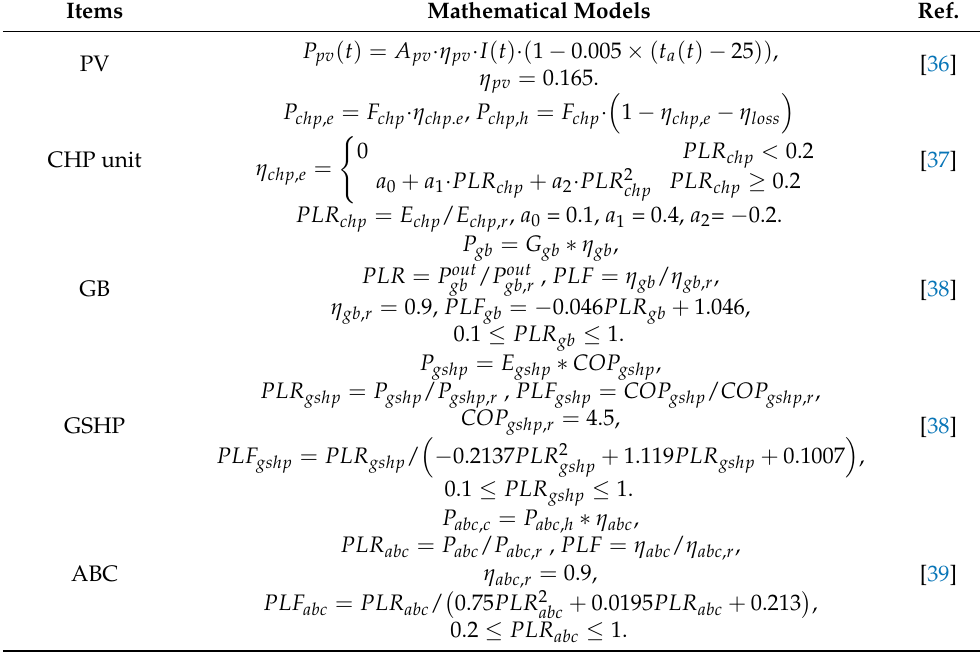
Table 3. Equipment dynamic